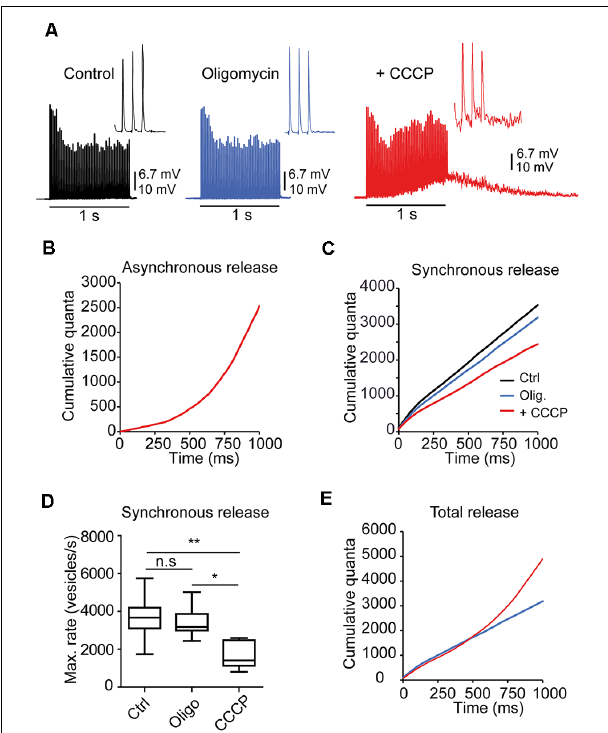
FIGURE 5 | Mitochondria regulate asynchronous release during brief AP trains. (A) Representative responses to 1-s stimulation trains (50 Hz) in a fiber recorded in control solution, oligomycin, and oligomycin plus CCCP. Note the elevation on the baseline during and after the train due to the prominent increase in asynchronous release in the presence of CCCP. The insets display the last three EPPs of the trains for each condition. (B) Cumulative asynchronous release during synaptic activity in CCCP (the same fiber as in A , estimated by integration, as described in “ Materials and Methods ” Section. (C) Cumulative synchronous quanta release from the fiber in (A) in all three solutions. (D) Average cumulative synchronous quanta release in control, oligomycin alone, and oligomycin plus CCCP (24 fibers, eight mice) (P Kruskal-Wallis = 0.0034). The box-whisker plot represents median (line), 25th–75th percentile (box), and min–max (whisker) for each condition. *:<0.05; **:<0.005; n.s., not significative. (E) Total quanta release (synchronous + asynchronous) in CCCP (red line). For comparison, release in oligomycin alone (blue line) is also